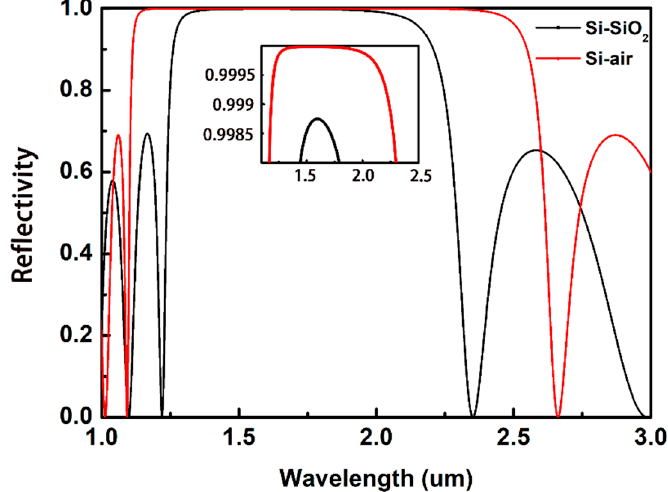
Figure 3. Stop bands of the designed DBRs. The inset shows the reflectivity of two DBRs around 1550 nm.